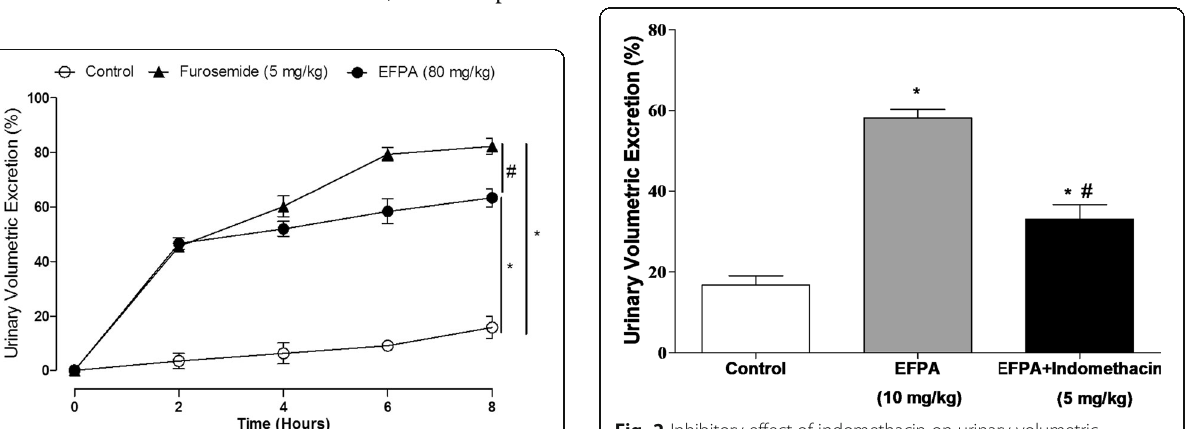
Fig. 2 Inhibitory effect of indomethacin on urinary volumetric excretion induced by EFPA in rats. Rats were treated over 8 h period with a single dose of either vehicle (control group), EFPA (10 mg/kg) or EFPA (10 mg/kg)+indomethacin (5 mg/kg, 1 h pretreatment) administered i.p. Data are given as means ± SEM of 6 different experiments. Statistical analyses were assessed using one-way analysis of variance (ANOVA) followed by Bonferroni ’ s post- test * p <0.05 versus control, and # p <0.05 versus